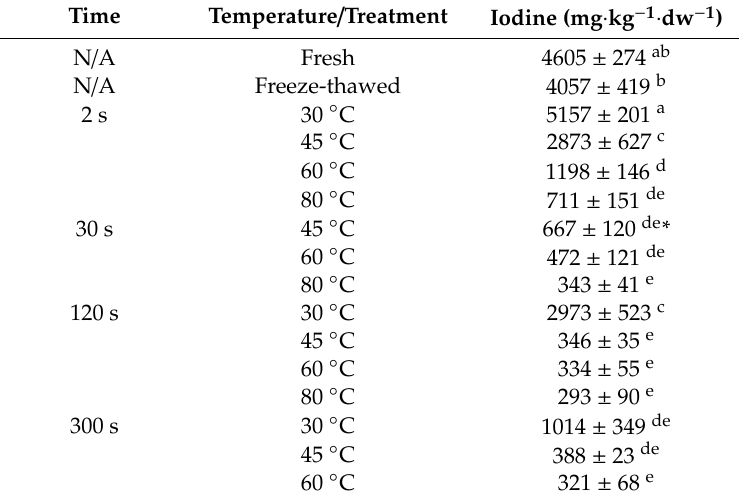
Table 1. Iodine content in fresh, freeze-thawed and water-blanched Saccharina latissima expressed